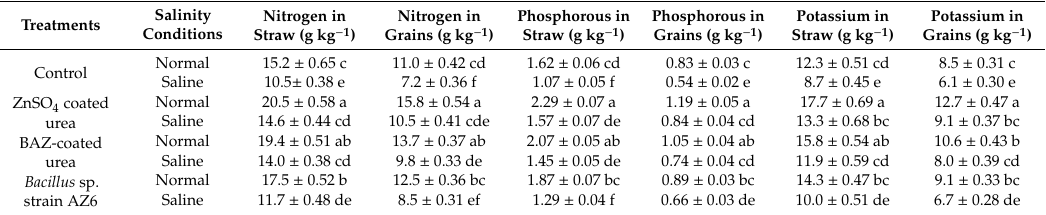
Table 4. The impact of BAZ ( Bacillus augmented ZnO)-coated urea on macronutrient contents of wheat under salinity stress.